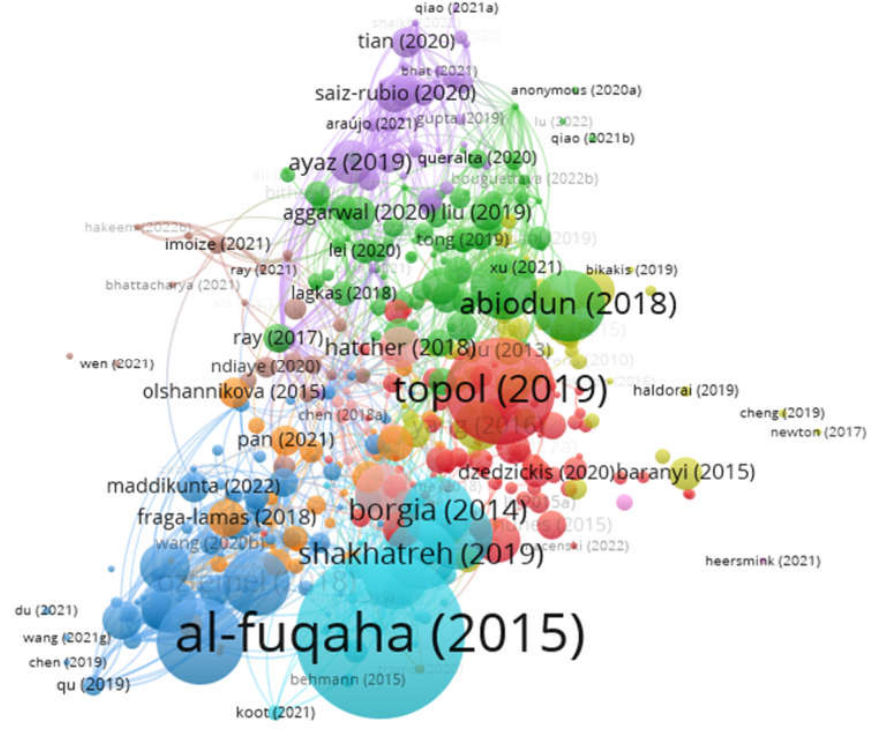
Figure 3. VOSviewer mapping of remote big data management tools, sensing and computing technologies, and visual perception and environment mapping algorithms in the Internet of Robotic Things regarding bibliographic coupling.